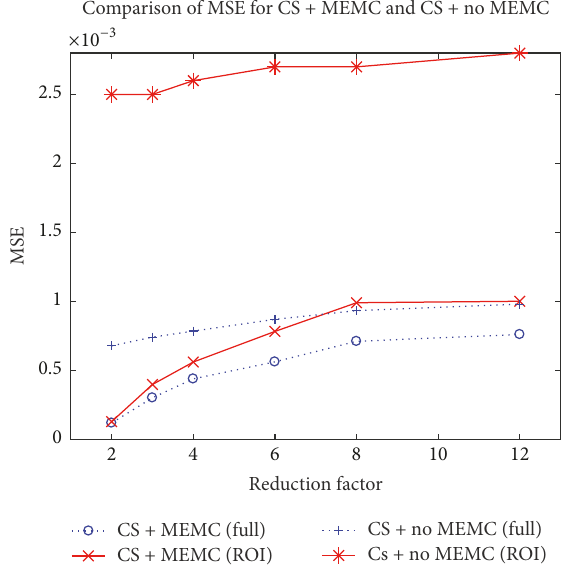
Figure 8: Performance comparison of MSE at different reduction factors for CS-free breathing and CS-free breathing motion cor- rected. Dotted lines depict MSE over the entire region and solid lines depict MSE in the region of interest